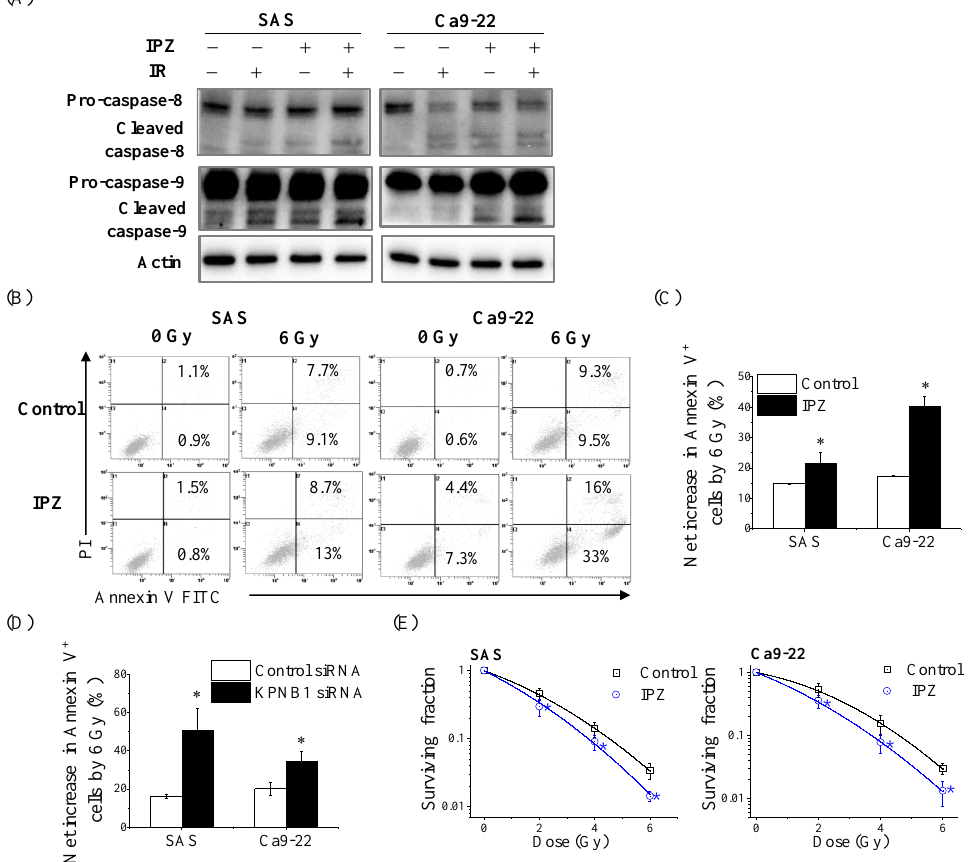
Figure 2. IPZ enhances the radiation-induced apoptosis and radiosensitivity of HNSCC cells. ( A ) IPZ (10 µ M) was added to the culture medium 1 h before X-ray irradiation. After 20 h-incubation, the cell-culture-conditioned medium was replaced with fresh media and the cells were further